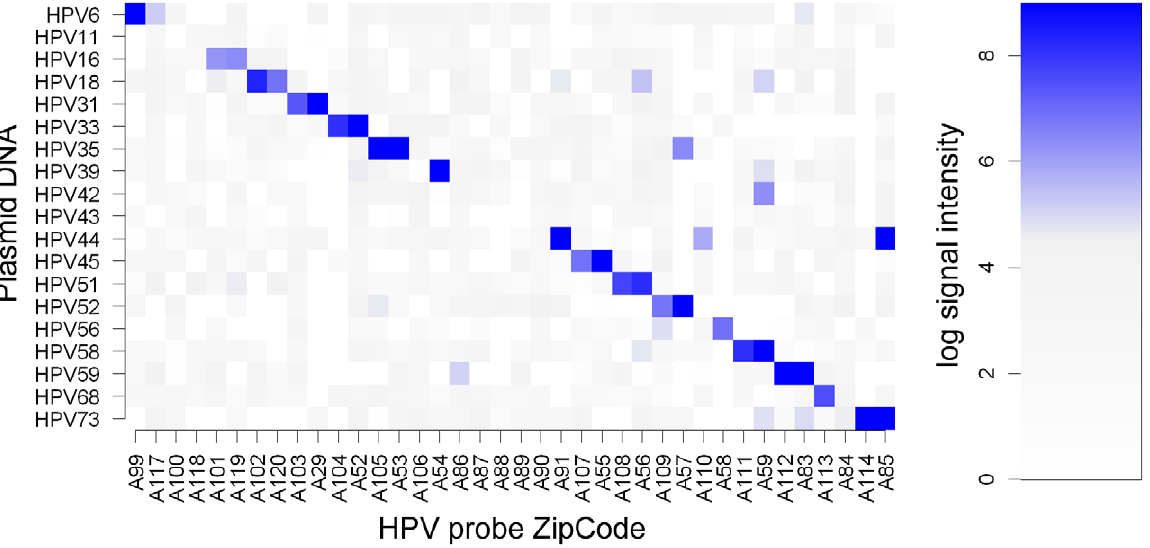
Figure 2. Specificity of HPV LDR probe pool. The HPV LDR probe pool was tested against individual plasmid templates. The horizontal axis shows the probes by ZipCodes and corresponding HPV types. The vertical axis shows plasmid templates by HPV type. The signals are medians over spot replicates on 1–3 microarrays. The majority of the probes give a high hybridization signal only for their specific target plasmids. For HPV 11, 42 and 43, there are no functional probes. HPVs 39, 56 and 68 have only one functional probe each. The probe A85 (HPV 73 ) shows a strong nonspecific hybridization signal to HPV 44 template. Minor nonspecific hybridisation signals are evident in probes A59, A110, A57 and A56.